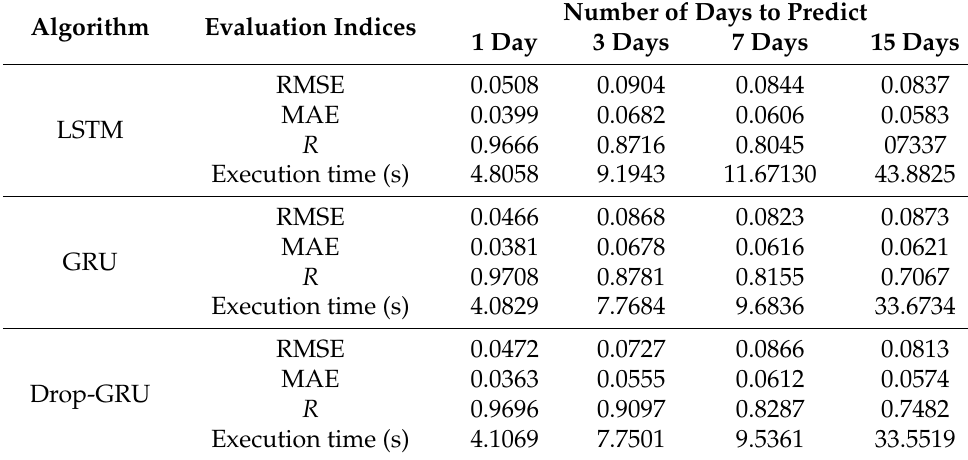
Table 3. Performance criteria of the studied